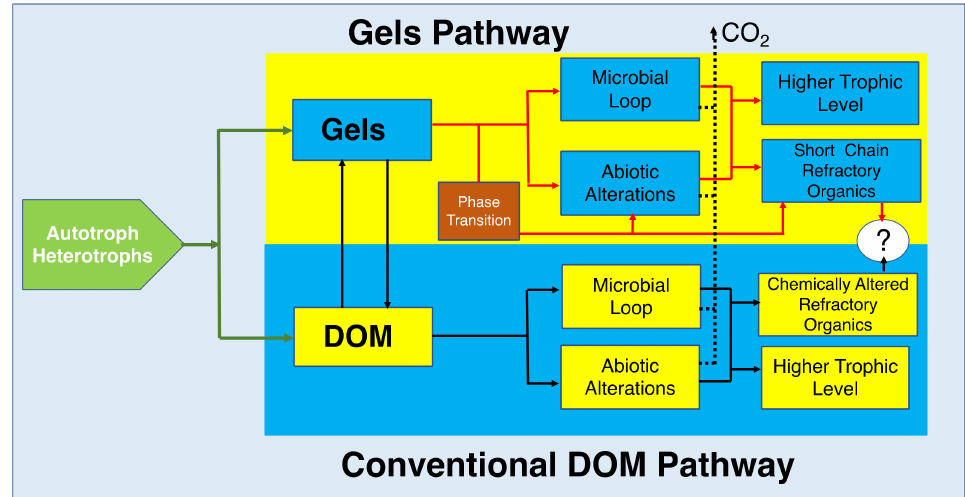
Figure 30. Molecular reduced-organic-carbon-carriers probably have multiple ways to move up through the marine consumer’s conveyor. Two hypothetical pathways are illustrated here; one that postulates that DOM becomes directly available to marine bacteria primarily based on their molecular weight. The other proposes that bacteria feed primarily in marine gels made of large HMW moieties. According to the DOM hypothesis, the pass for moieties to become refractory is by potential chemical alterations that make these molecules resistant to bacterial enzymes. The Gel pathway hypothesis postulate that, while there are chemically altered species in SW, refractory molecules are simply those too large to be metabolized by bacteria and too small to self assemble. Implicit in this statement is the notion that marine gels are necessary and probably sufficient to drive carbon flux dynamics in the